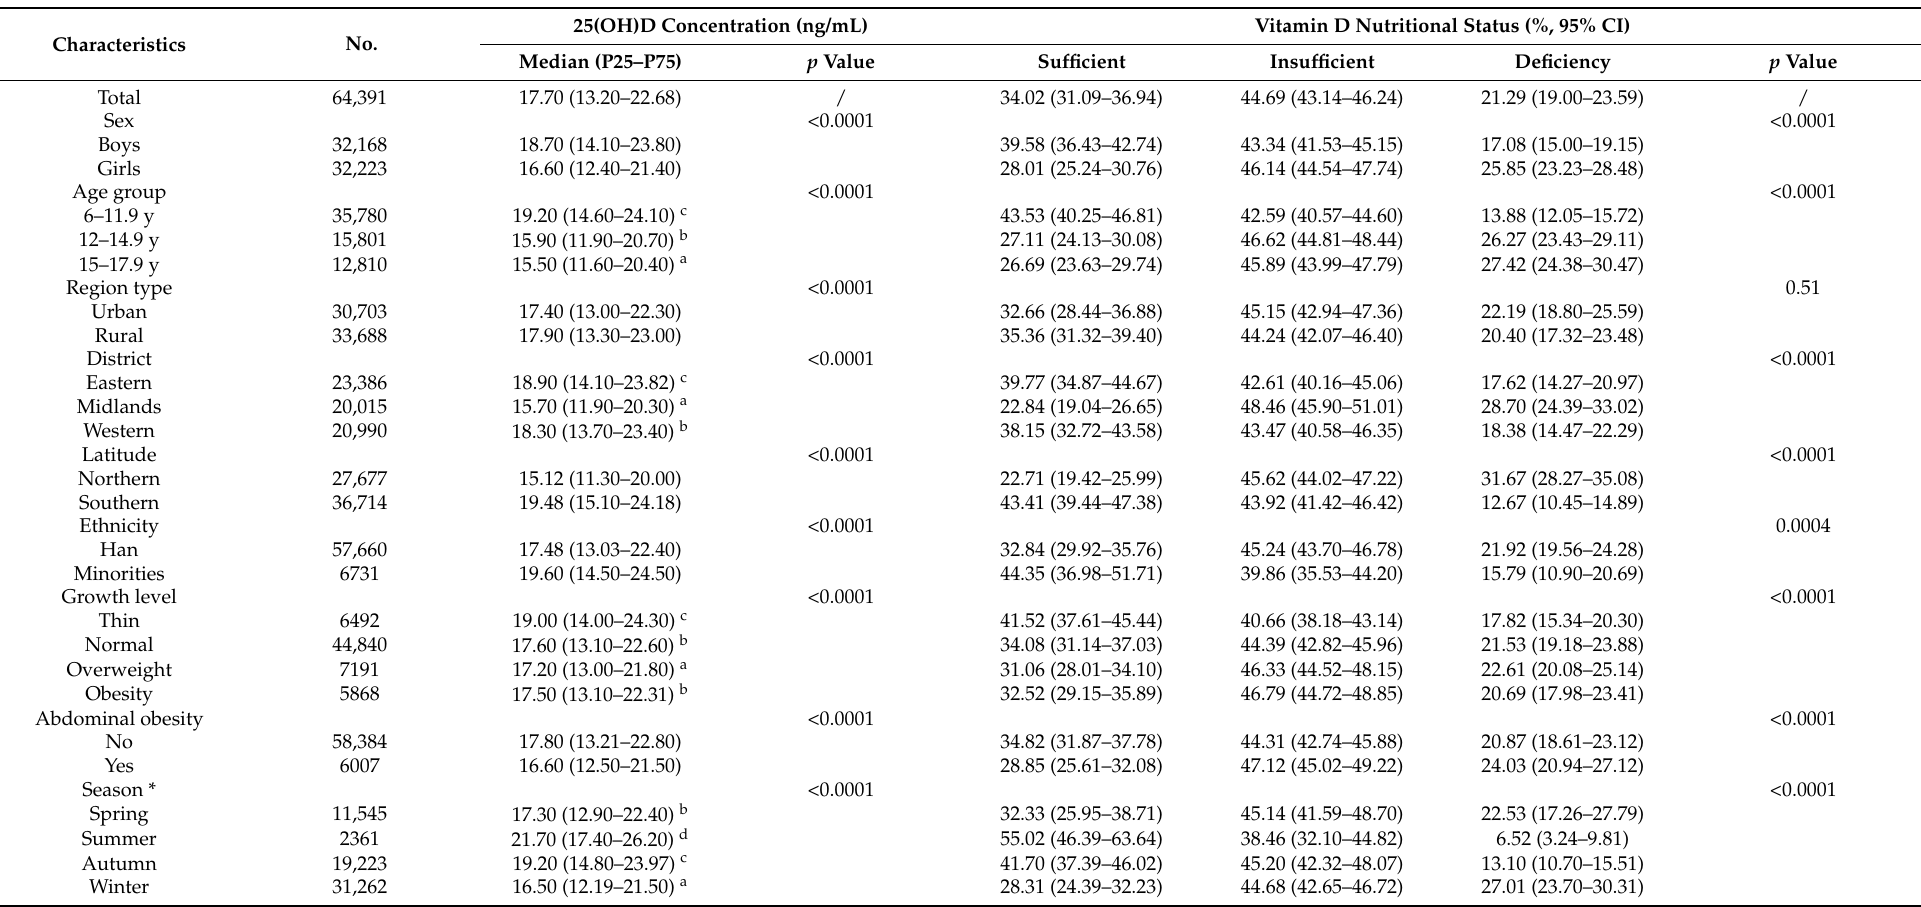
Table 1. Serum 25(OH)D concentration and vitamin D deficiency for children and adolescents from China National Nutrition and Health Survey of Children and Lactating Mothers in